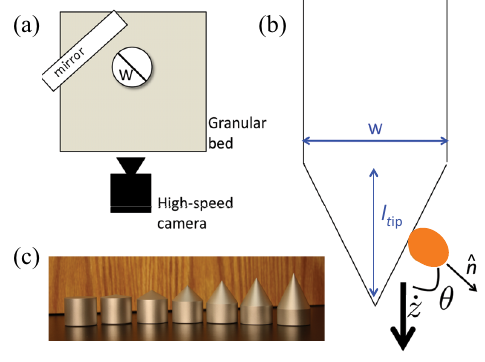
Figure 1. (a) Top view of experiment setup. A mirror is placed at 45 degrees to the impact to measure any tilting during penetra- tion. (b) Diagram of the impact of a conical intruder with a chain of particles within the granular target (orange ellipse). (c) Image of intruders of w = 3.8cm, varying s .